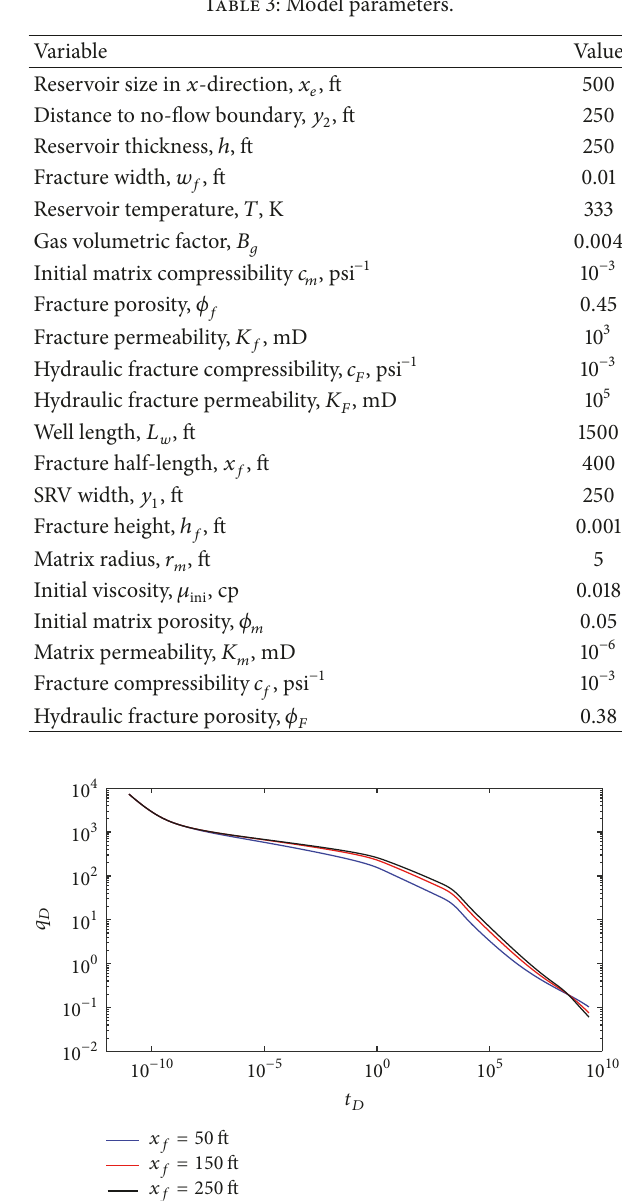
fracture and the shale gas reservoir is larger when the fracture half-length is longer. Therefore, when gas flow resistance is reduced, more shale gas can flow to the fracture. Further- more, larger flow rate results in significant pressure drop and a larger